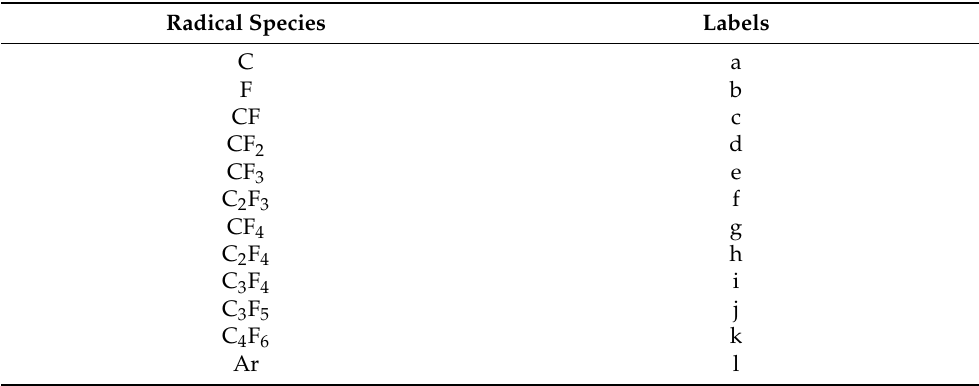
Table 2. Labels to be displayed in Figures 4a, 6a and 8a substituting each radical species to labels. Radical